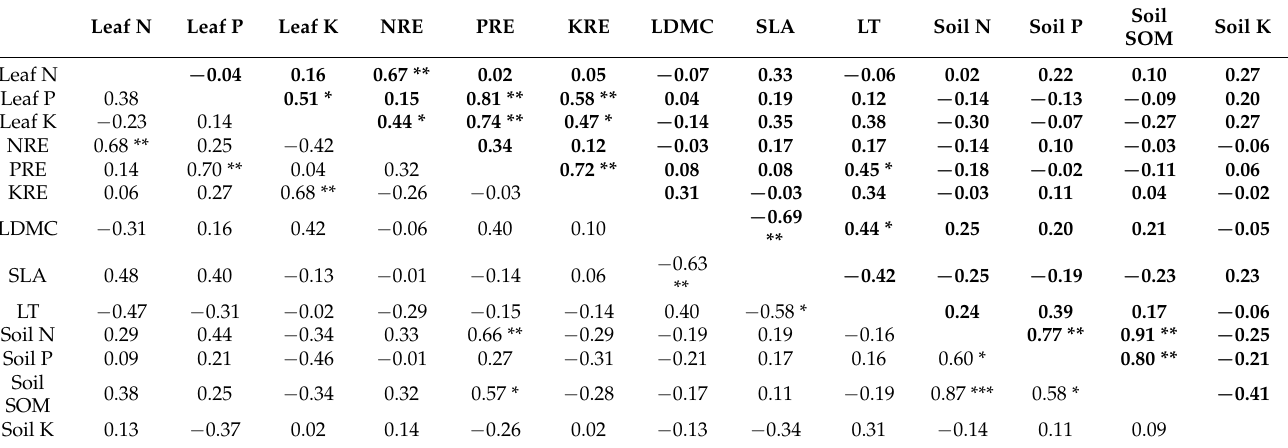
Table 4. The correlation analysis between nutrient resorption efficiencies, leaf traits, and soil nutrients under both disturbances in the Phoebe bournei